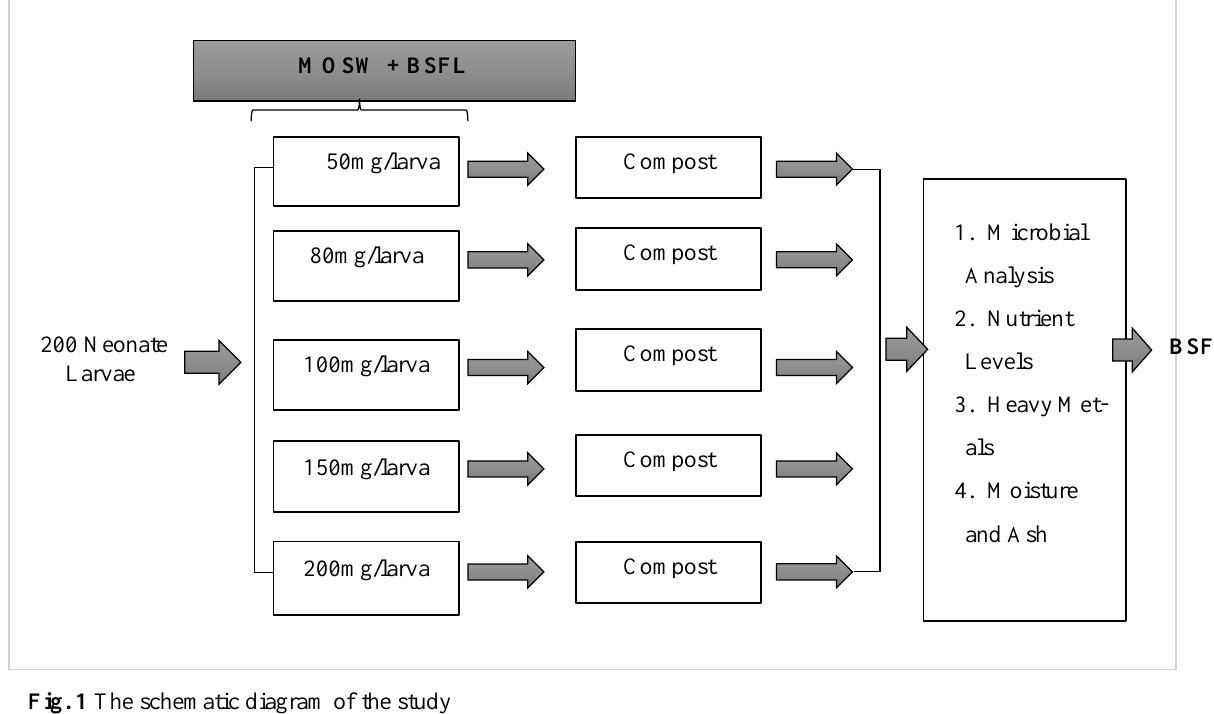
Fig. 1 The schematic diagram of the study